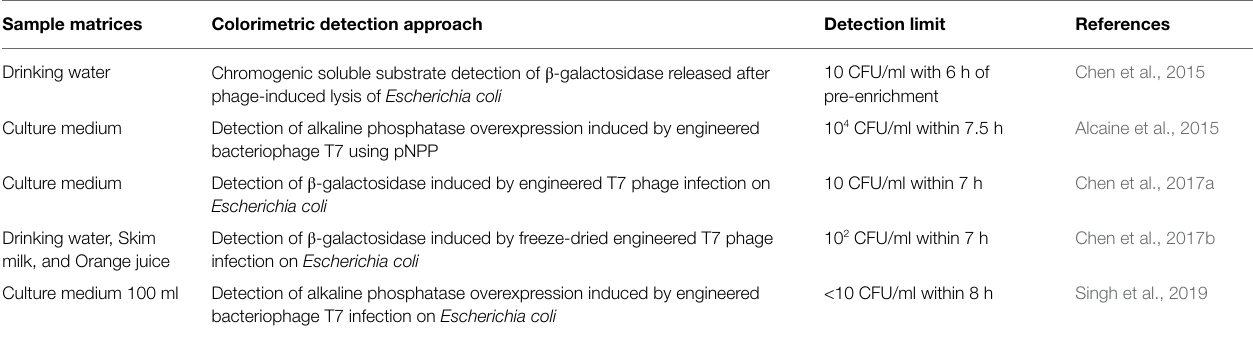
TABLE 4 | Summary of the previous studies on colorimetric bacteriophage-based detection of E. coli . Sample